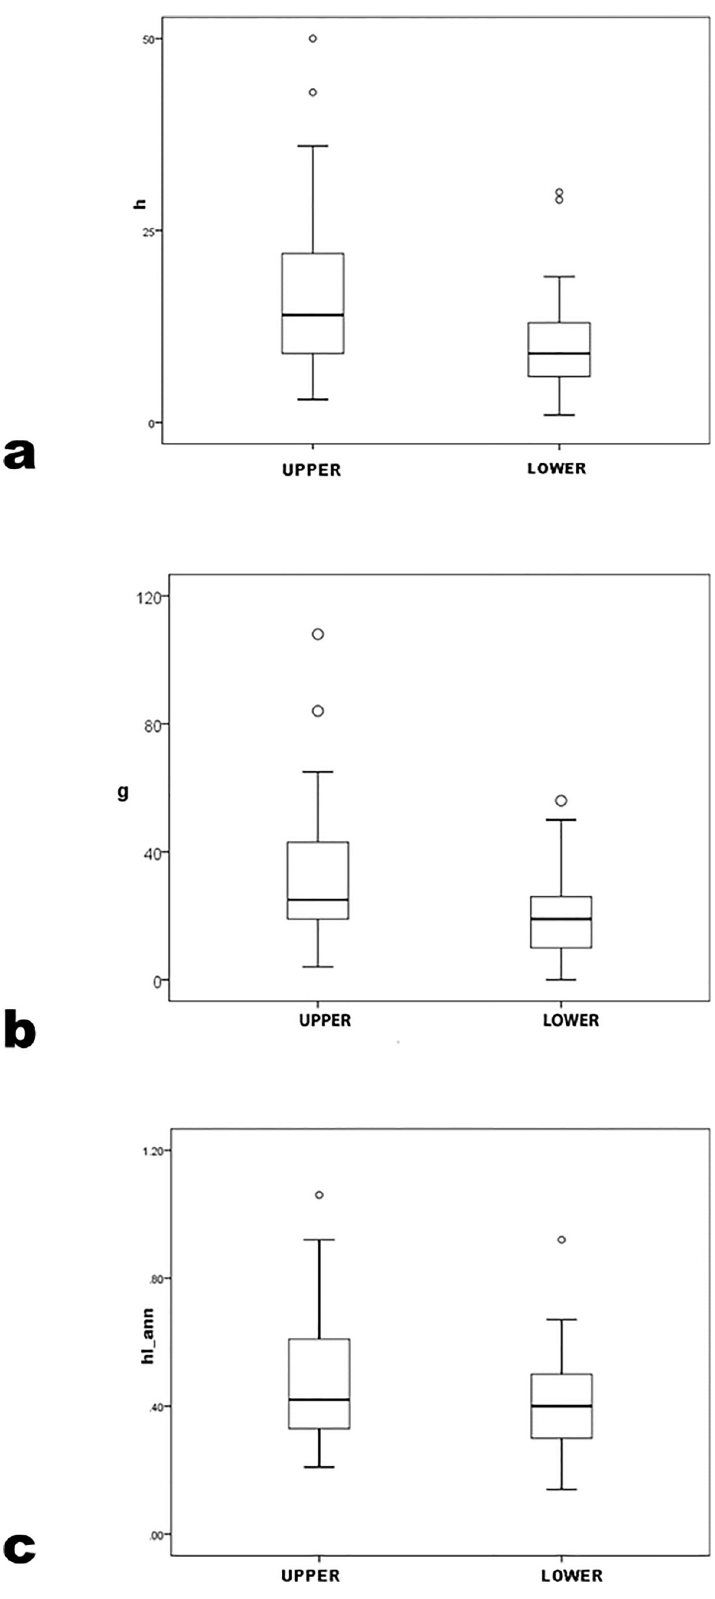
Fig 9. h , g and hIann by NRC-rank top and bottom